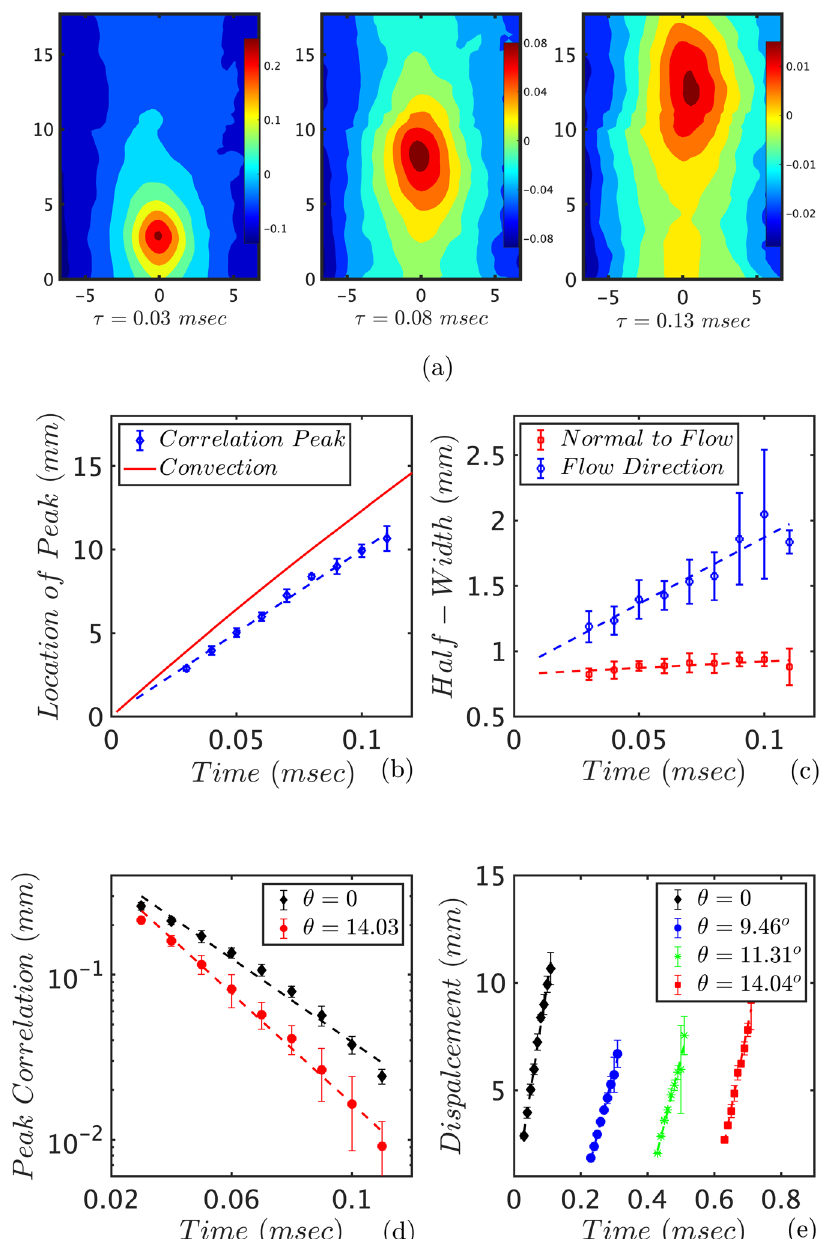
Fig. 2 Properties of time-delayed cross-correlation functions. a Three snapshots of the fi eld C R ¼ 0 ; R 0 ; τ ð Þ , whose peak fl ows downstream and broadens in time. Distances are given in mm and the center of the near-boundary is chosen as the origin. Panels b – e show mean values (symbols) and standard deviations (error bars) of variables computed from four non-overlapping subintervals, each of 1500 snapshots. b The downstream velocity of the peak (blue diamonds) is smaller than the convection velocity (red line). c The width of the peak, both in the fl ow direction (blue circles) and normal to it (red circles), grows linearly in time. d The peak P z ( τ ) ( fl ow direction: θ = 0, black diamonds) decays exponentially in time. e Velocity of the peak is nearly independent of the direction within a cone. The lines (shifted for clarity) show the peak locations as a function of time for the fl ow direction (black diamonds) and for directions θ = tan − 1 (1/6) (blue circles), tan − 1 (1/5) (green crosses), and tan − 1 (1/4) (red squares) from the fl ow axis. However, as seen in d , the peak intensity decays faster away from the fl ow direction (red